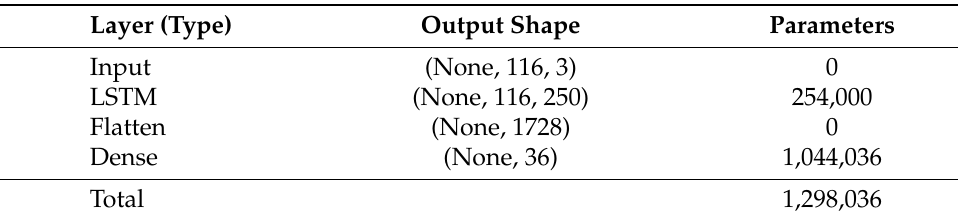
Table 3. Number of parameters of the LSTM architecture.